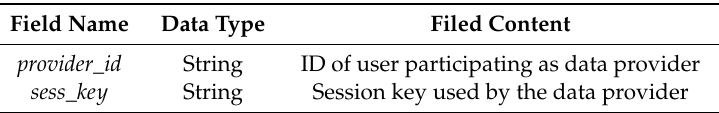
Table 6. Schema of participant database.